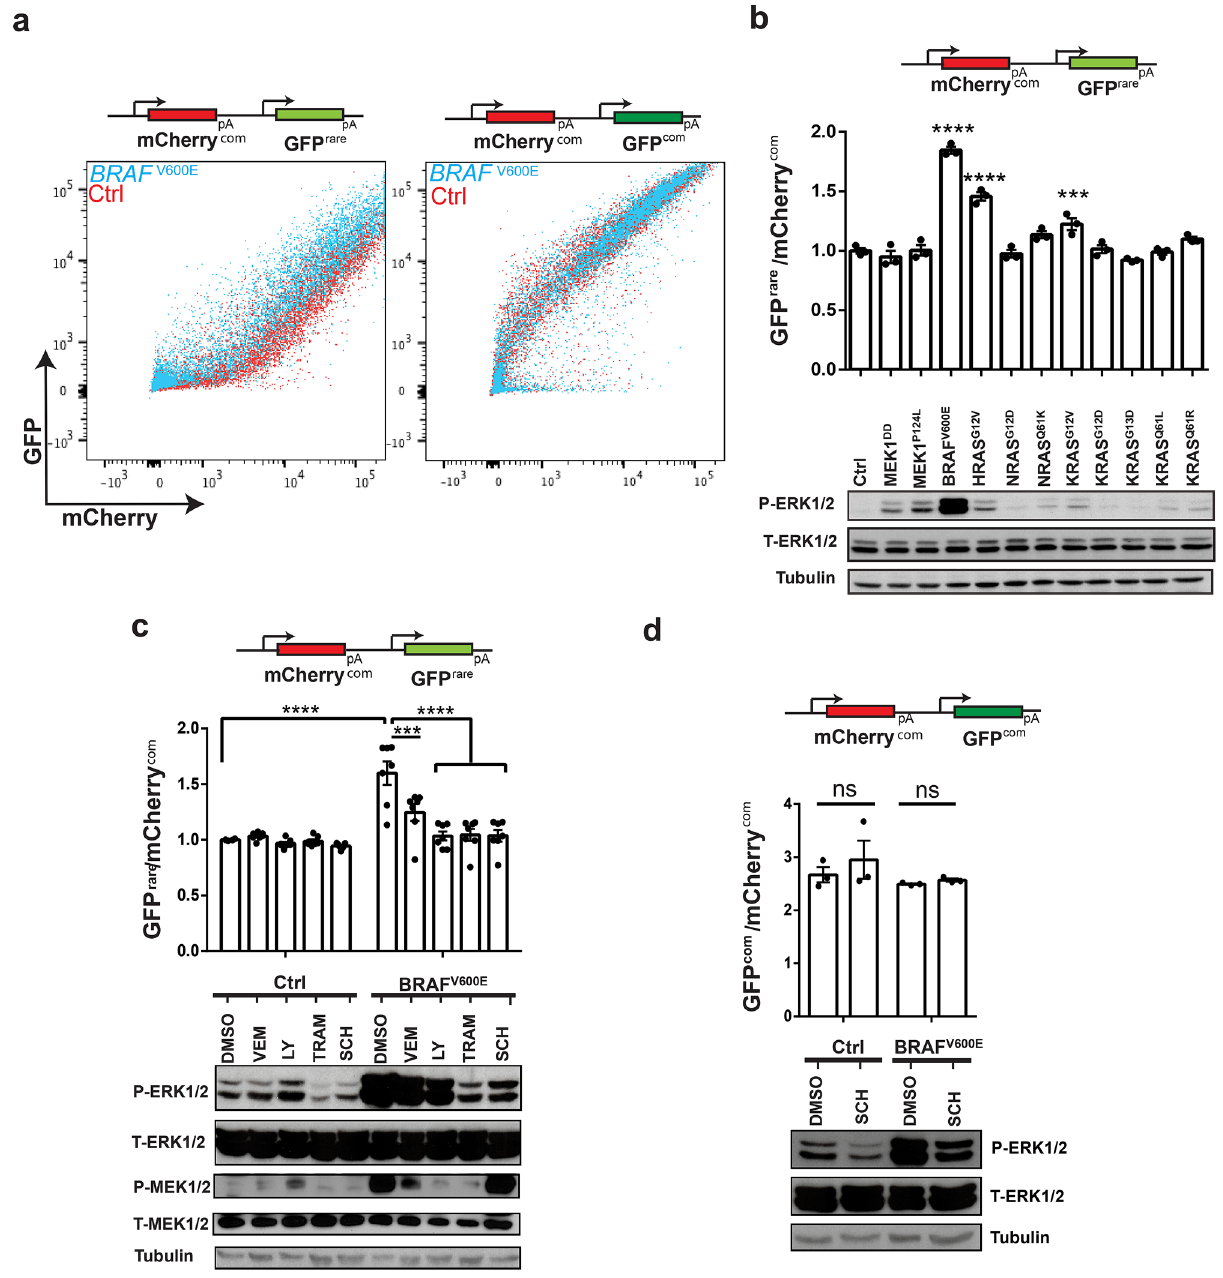
Figure 2. The MAPK pathway enhances GFPrare expression. ( a ) Reporter used (top) and degree of GFP versus mCherry fluorescence, as assessed by FACS, of 293T cells stably expressing either control (Ctrl) luciferase (red dots) or BRAF V600E (blue dots) when transfected with the indicated reporters (bottom). One of three biological replicates. ( b – d ) Reporters used (top), mean ± SEM of the ratio of ( b , c ) GFP rare to mCherry com or ( d ) GFP com to mCherry com fluorescence normalized to the fluorescence of parallel luciferase control (Ctrl) cells for three technical replicates (middle), and immunoblot analysis of phosphorylated (P) and total (T) ERK1/2 and when tested MEK1/2, with tubulin serving as a loading control (bottom), for 293T cells stably expressing the luciferase control (Ctrl) and ( b ) the indicated oncogenes or ( c , d ) BRAF V600E when transfected with the indicated reporter and, when denoted, after treatment with MAPK inhibitors: vemurafenib (vem), LY3009120 (LY), trametinib (TRAM) or SCH772984 (SCH). One of two or three biological replicates. P values in ( b ) were calculated from comparison against luciferase control. One-way ( b ) or two-way ANOVA ( c , d ) with Sidak’s multiple comparisons test: ns: P ≥ 0.5, *** P < 0.001 and **** P <